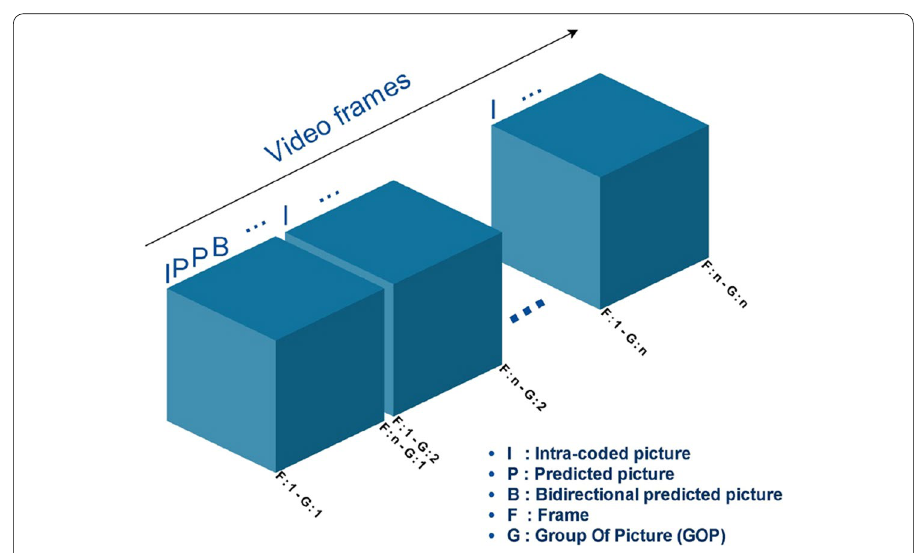
Fig. 2 Video frame types of a Group Of Picture